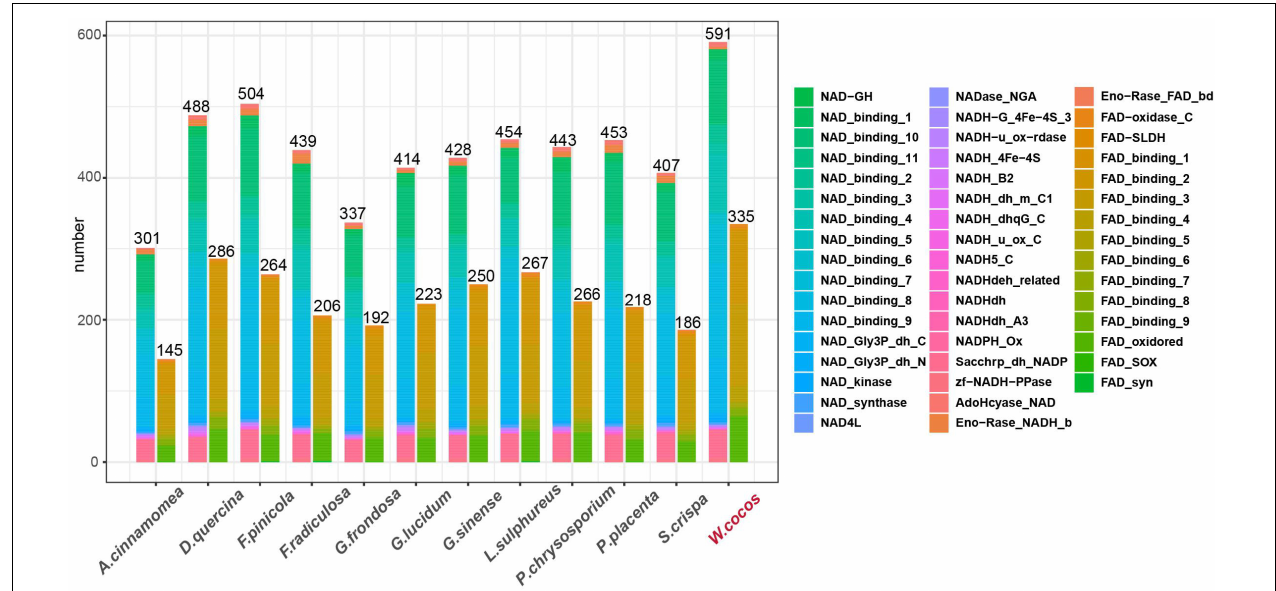
FIGURE 6 | The numbers of nicotinamide adenine dinucleotide (NAD)- and FAD-related domains in WCLT and other representative fungi in Polyporaceae . The domains were predicted by Pfam 3.1.0; the right side of the figure indicates different family